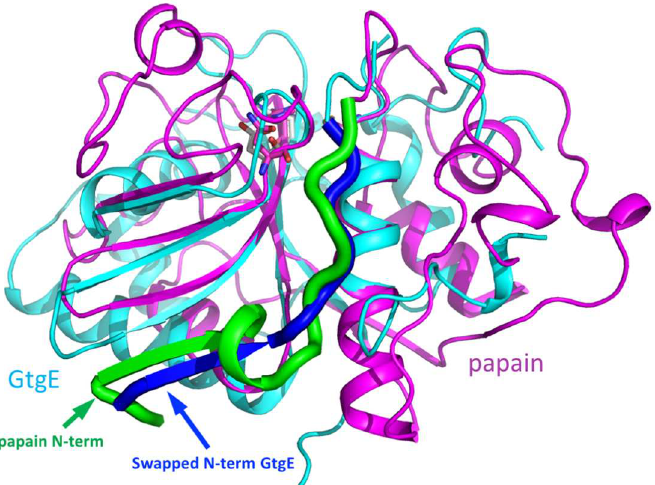
Fig 4. Superposition of GtgE (cyan) and papain (magenta). Papain structure used for the comparison has PDB code 3CVZ [33]. (A) The N-terminus of papainis shown as a thick green ribbon. The swappedN- terminus of GtgE from a neighboring moleculeis shown as a thick blue ribbon. GtgE and papainsuperimpose well within the core of the fold, enclosedwithin the blue circle. (B) Close-upof the catalytic triads Cys-His-Asp/ Asn in this superposition. The Ser45 of GtgE was replacedhere by a cysteine and the sidechainof His151 was rotated by 180˚. The catalytic residues are shown in stick representation, magentacarbons in papain, white carbonsin